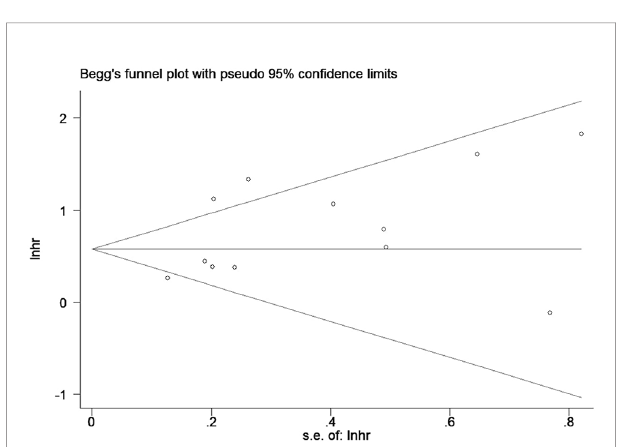
FIGURE 6 | Begg ’ s funnel plots for detecting publication bias of the association between neutrophil-lymphocyte ratio (NLR) and overall survival of multiple myeloma